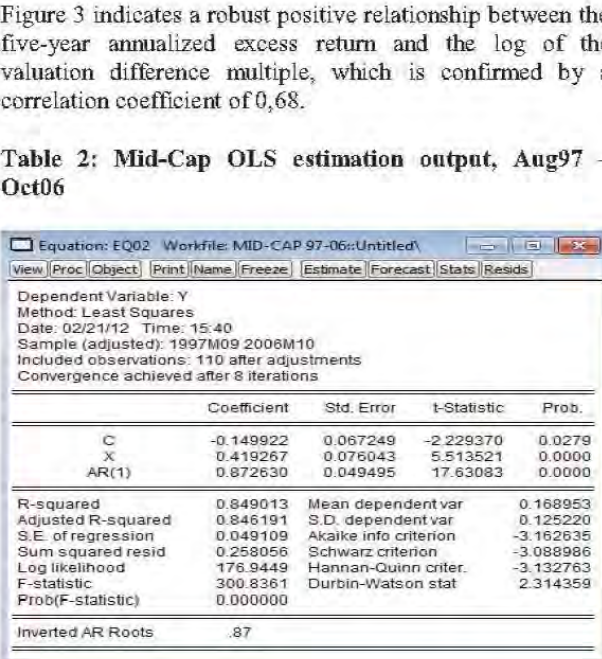
Figure 2: Large-Cap linear regression line, Jan91 - Oct06 Figure 3: Mid-Cap linear regression line, Aug97- Oct06